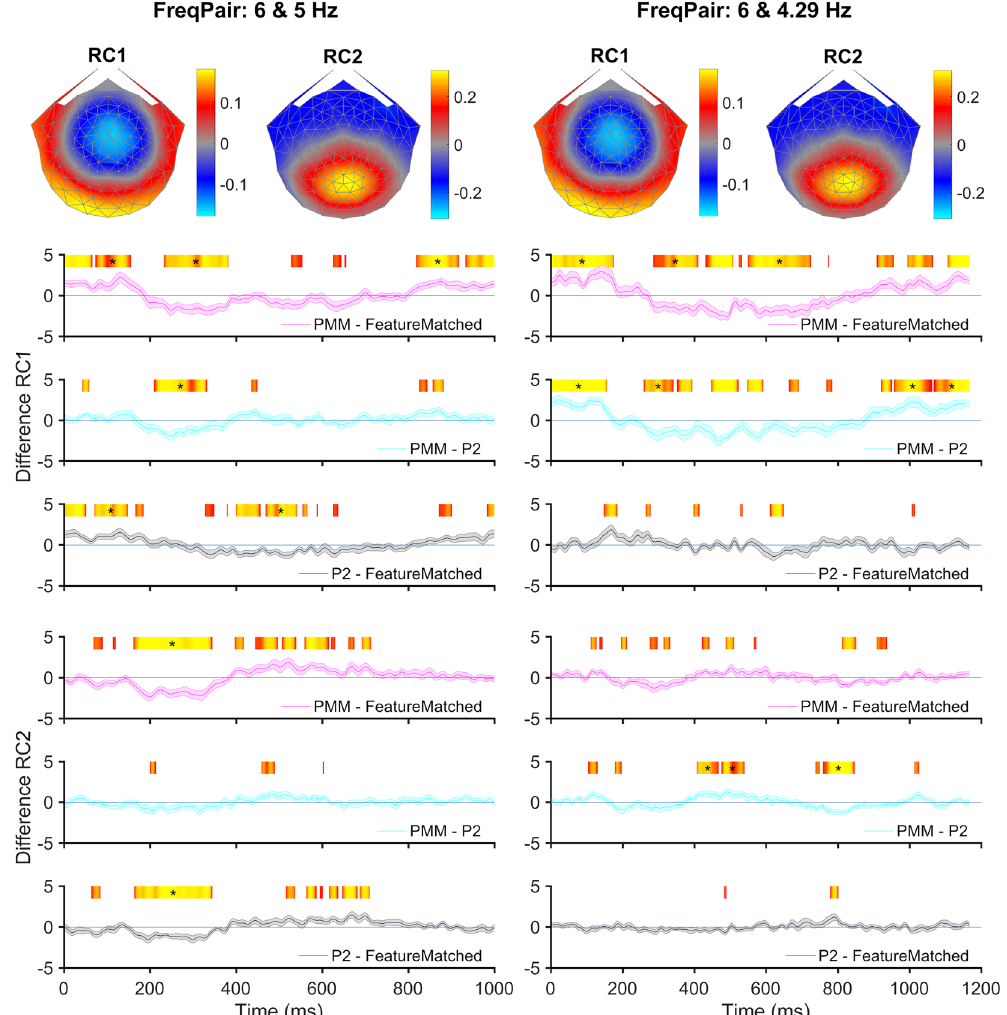
Figure 5. The time domain responses. Topographies and amplitude differences of two RCs for both frequency pairs are shown. The X axis represents the time for the mutual cycle of both frequencies per frequency pair. The Y axis shows the amplitude differences of RCs. Columns indicate two different frequency pairs, while rows indicate two RCs. The heat map is used to show the longest consecutive run of significant p values for a two- tailed t-test on difference RC amplitude separately. Difference RC amplitude was shown with pink (for PMM − feature-matched), cyan (for PMM − P2) and gray (for P2 − feature-matched) with error bars indicating the standard error of the mean. The heat map bars with a yellow-orange arrangement on top of each plot indicate uncorrected significant (p < 0.05) time points. Orange indicates p-values < 0.05, while yellow indicates smaller p-values. Asterisks are indicative of time points that are significantly longer than an expected chance level computed by the permutation